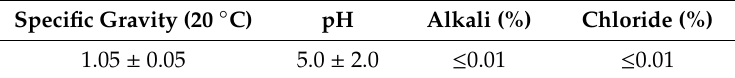
Table 5. Properties of